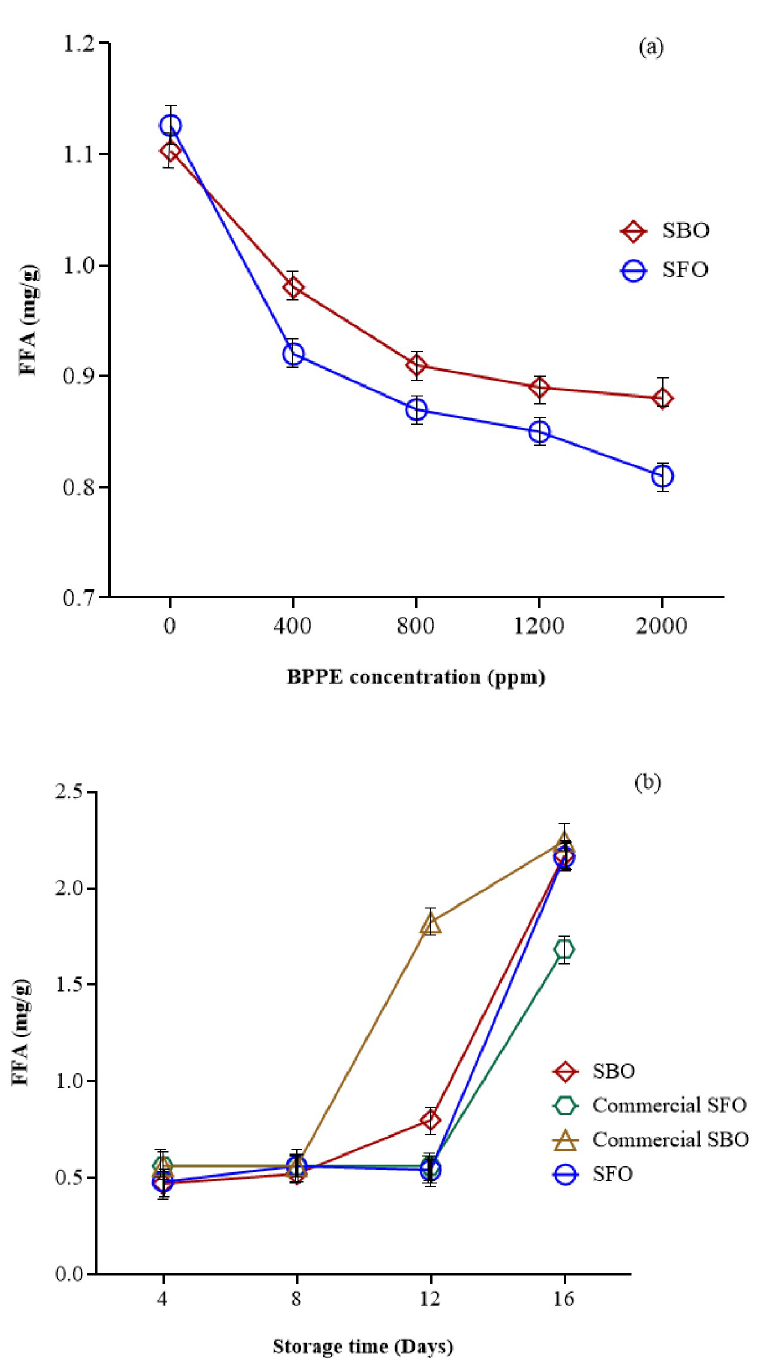
Fig 3. The effect of a) BPPE concentration � and b) storage time � on FFA of SBO and SFO. (BPPE: Black plum peel extract, Soy: Soybean oil, Sun: Sunflower oil, CSoy: Commercial soybean oil, CSun: Commercial sunflower oil) � (P �